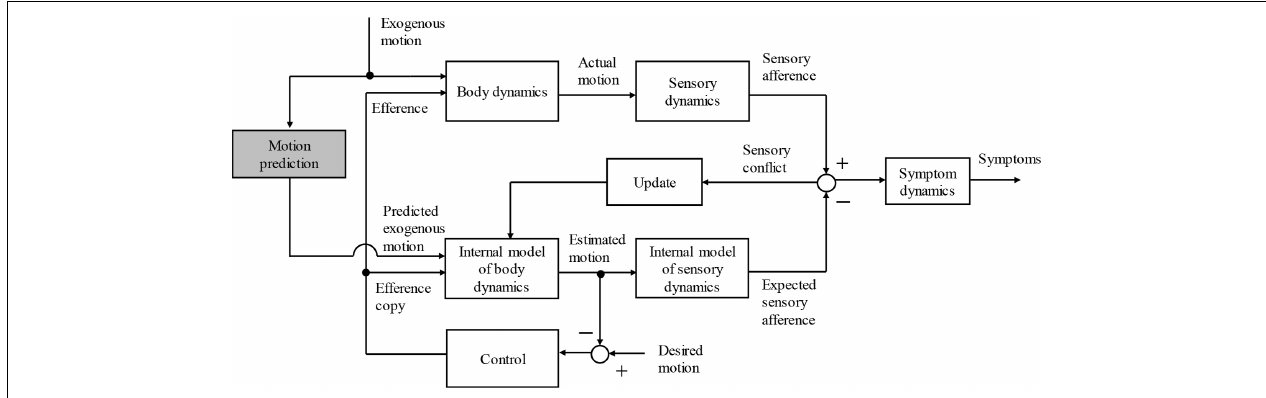
FIGURE 2 | Schematic block diagram of sensory conflict theory capable of capturing the effect of human prediction of exogenous motion disturbance.